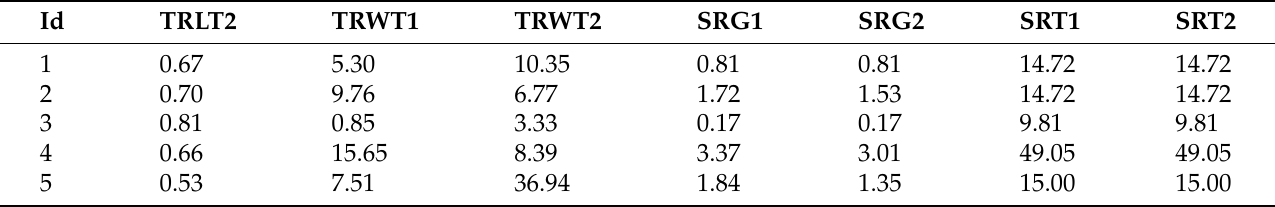
Table 10. Continuation of Table